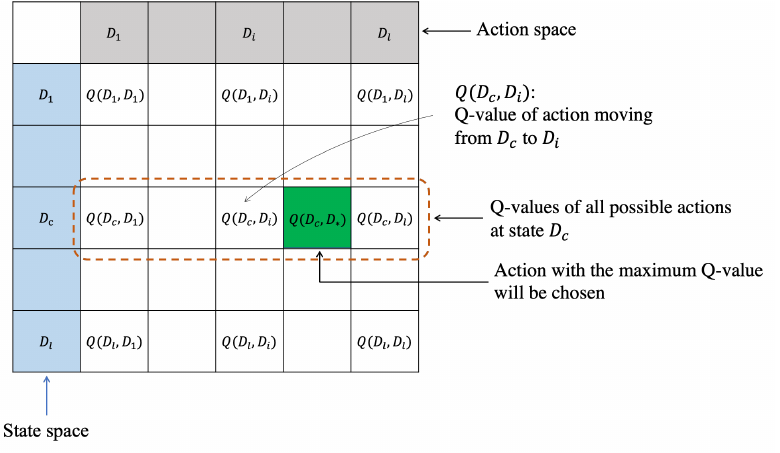
Figure 4. An illustration of the